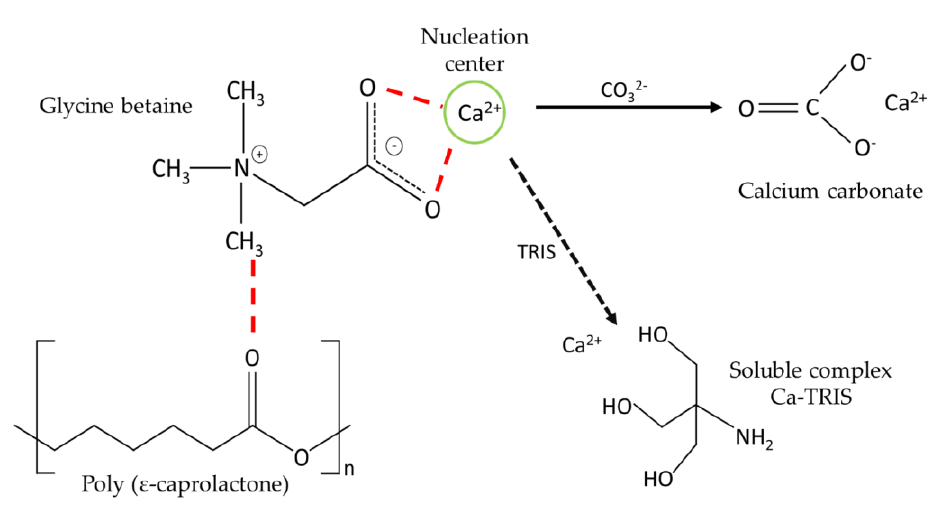
Figure 9. Schematic representation of the interaction between P, G, TRIS, and Ca 2+ . Table 2. Crystal sizes of calcite (C) and vaterite (V) obtained in GD crystallization assays on the